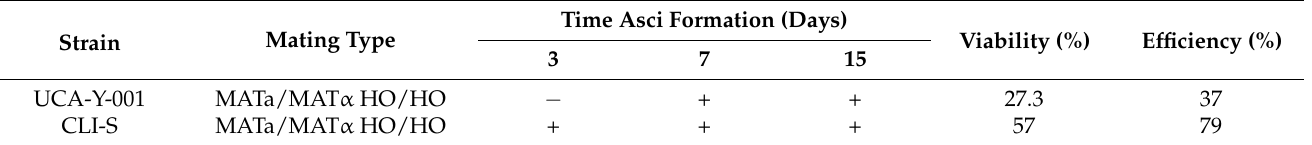
Table 1. Mating type, sporulation efficiency, and spore viability of the parental yeast strains (UCA-Y- 001 and CLI-S).